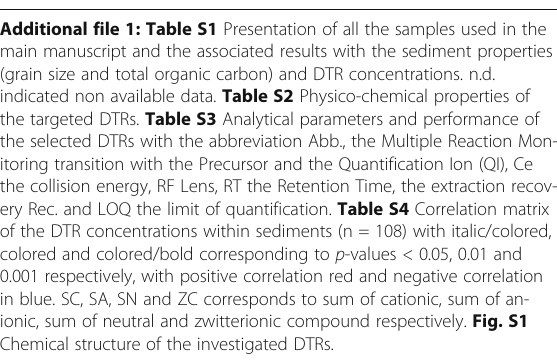
(grain size and total organic carbon) and DTR concentrations. n.d. indicated non available data. Table S2 Physico-chemical properties of the targeted DTRs. Table S3 Analytical parameters and performance of the selected DTRs with the abbreviation Abb., the Multiple Reaction Mon- itoring transition with the Precursor and the Quantification Ion (QI), Ce the collision energy, RF Lens, RT the Retention Time, the extraction recov- ery Rec. and LOQ the limit of quantification. Table S4 Correlation matrix of the DTR concentrations within sediments (n = 108) with